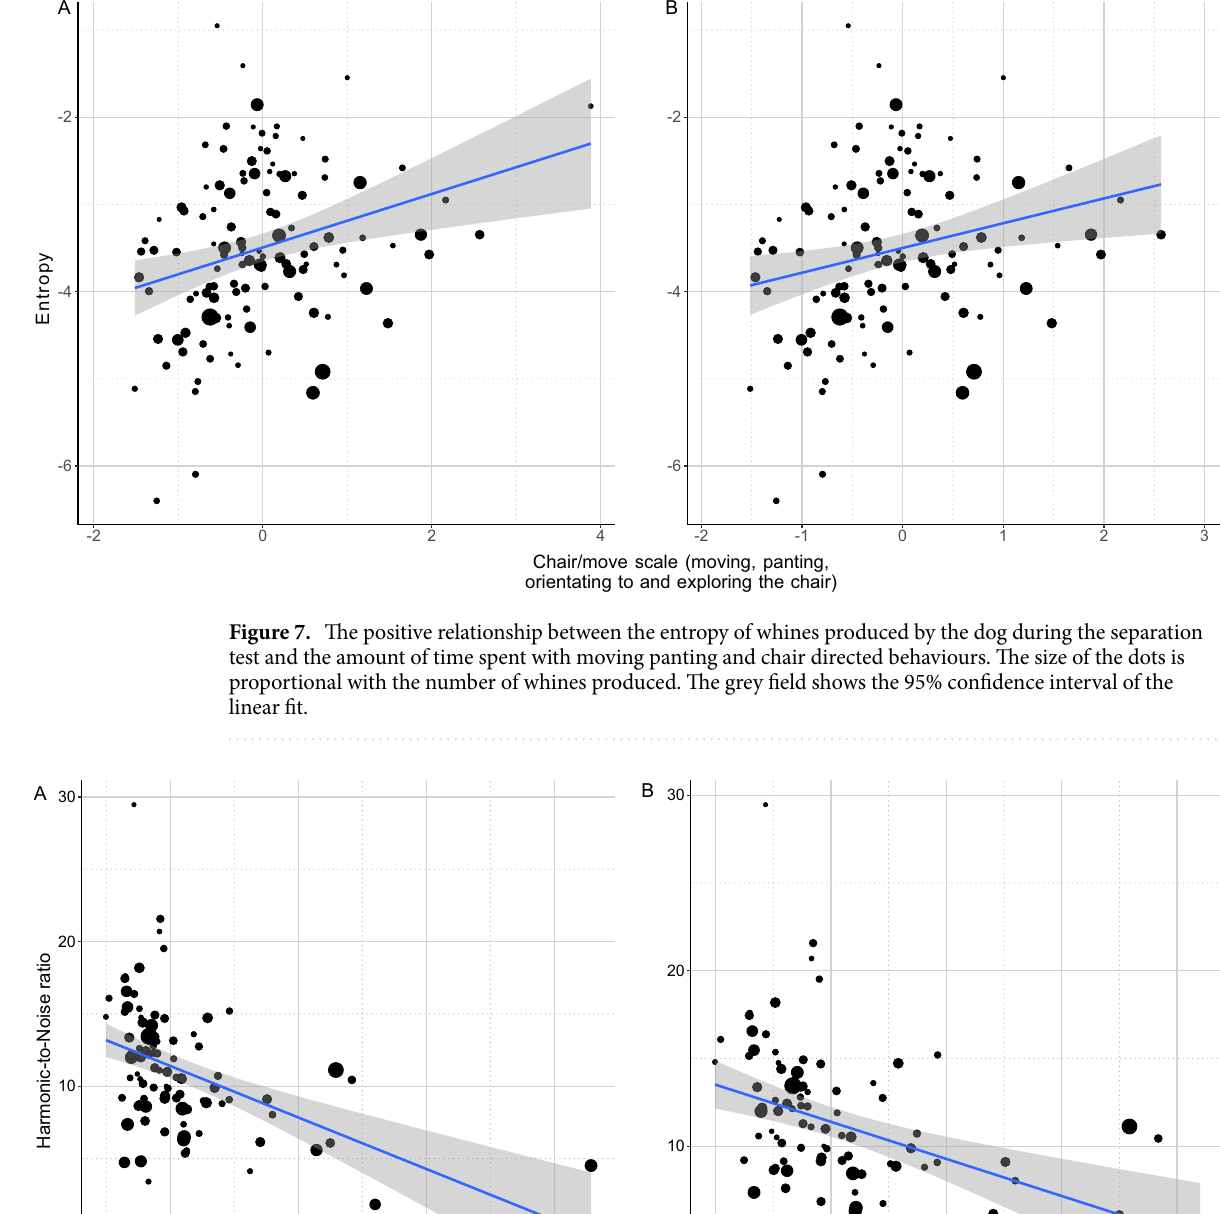
Figure 8. Figure The negative relationship between HNR and the dog’s escape activity during the separation test. The size of the dots is proportional with the number of whines produced. The grey field shows the 95% confidence interval of the linear fit. The significant negative effect remains even after excluding the extreme values (Escape scale >